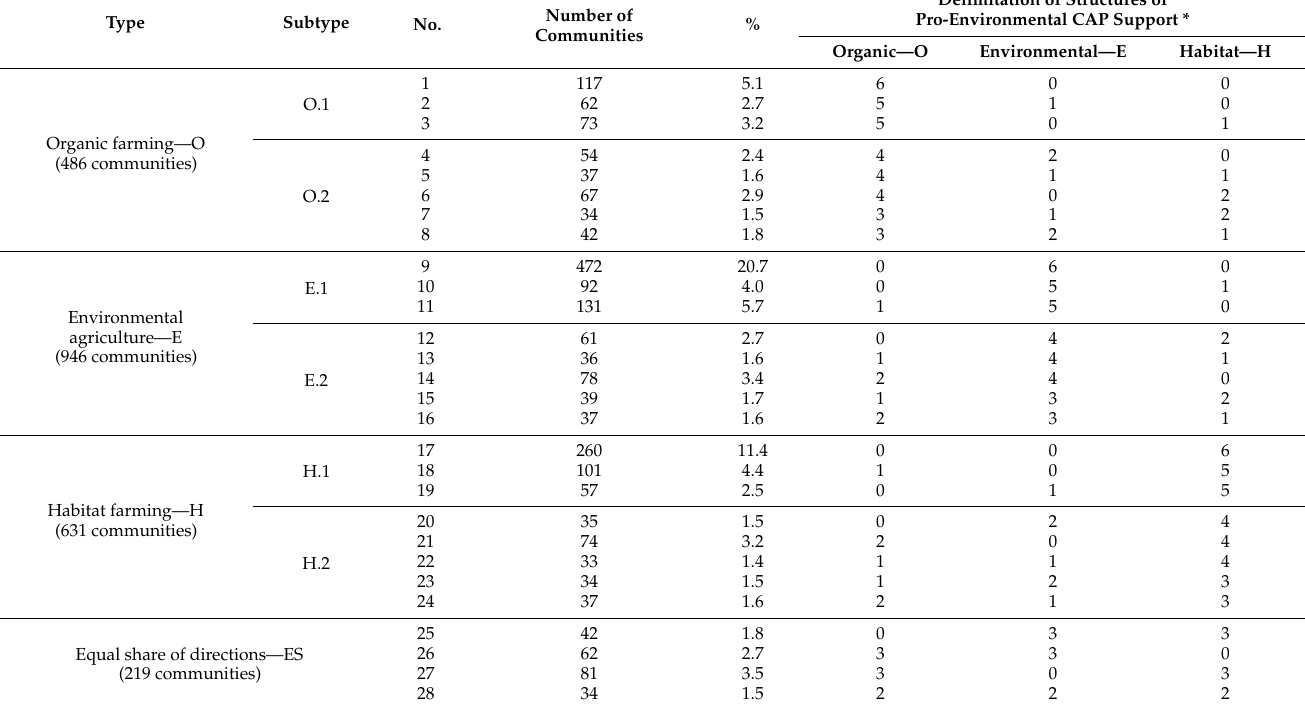
Table 3. Pro-environmental forms of CAP support: distribution of subsidised land by support type (100% = 2282 communities). Type Subtype No.